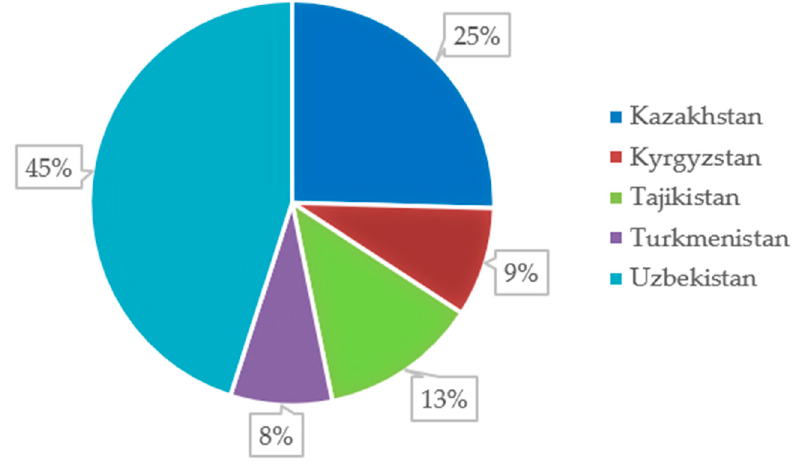
Figure 6. Population of Central Asian Countries, percentage. Source: FAOstat, 2021. Available online: www.fao.org (accessed on 26 May 2021)